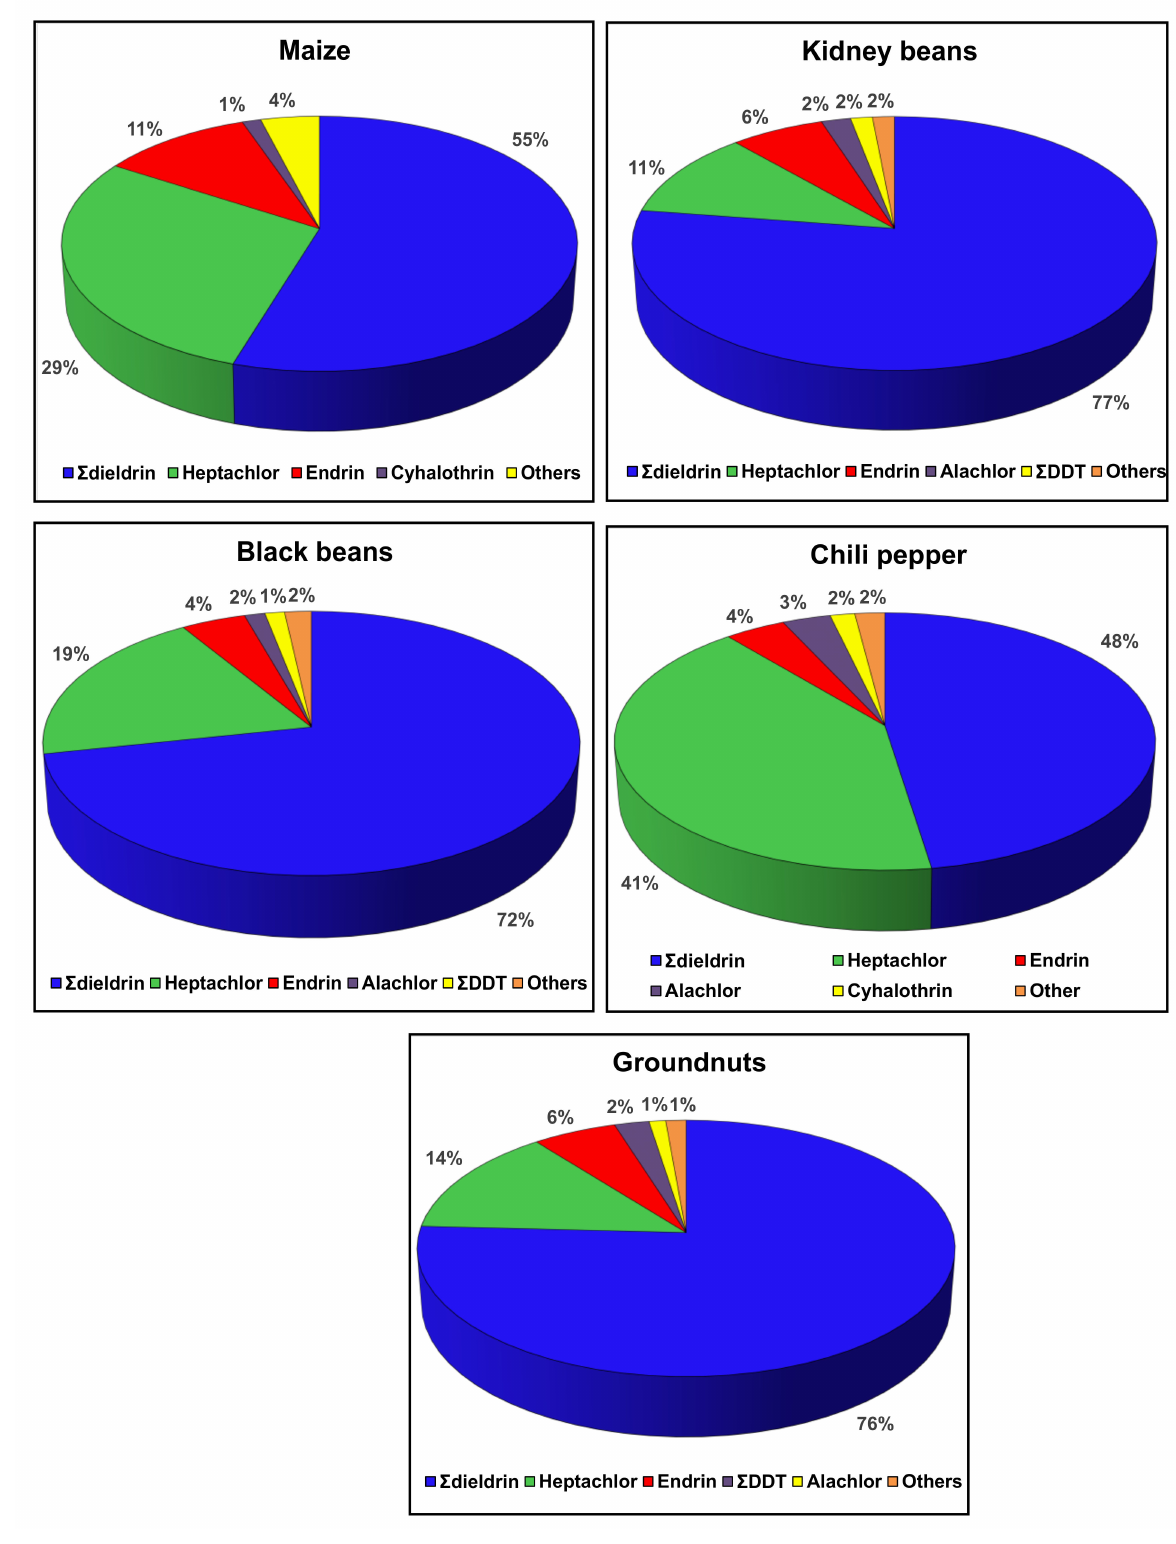
Figure 5. Relative contribution of halogenated pesticide compounds to the cumulative chronic health risk of food items from the 3 largest cities of Cameroon. Σ DDT = p,p’-DDT + op’-DDT + pp’-DDD + pp’-DDE. Σ dieldrin = aldrin +